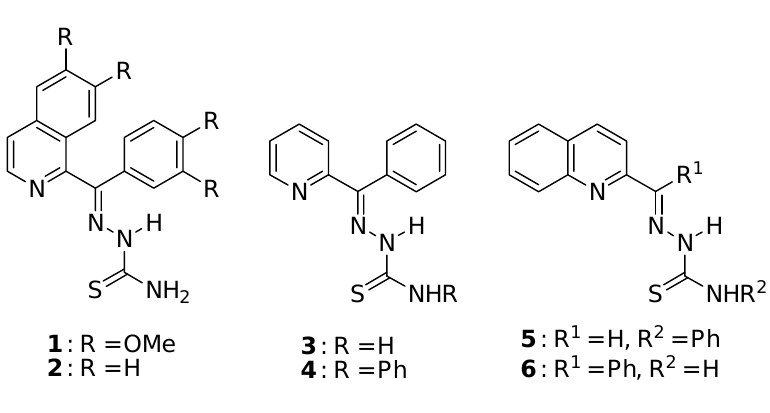
Figure 2. Thiosemicarbazone derivatives 1 – 6